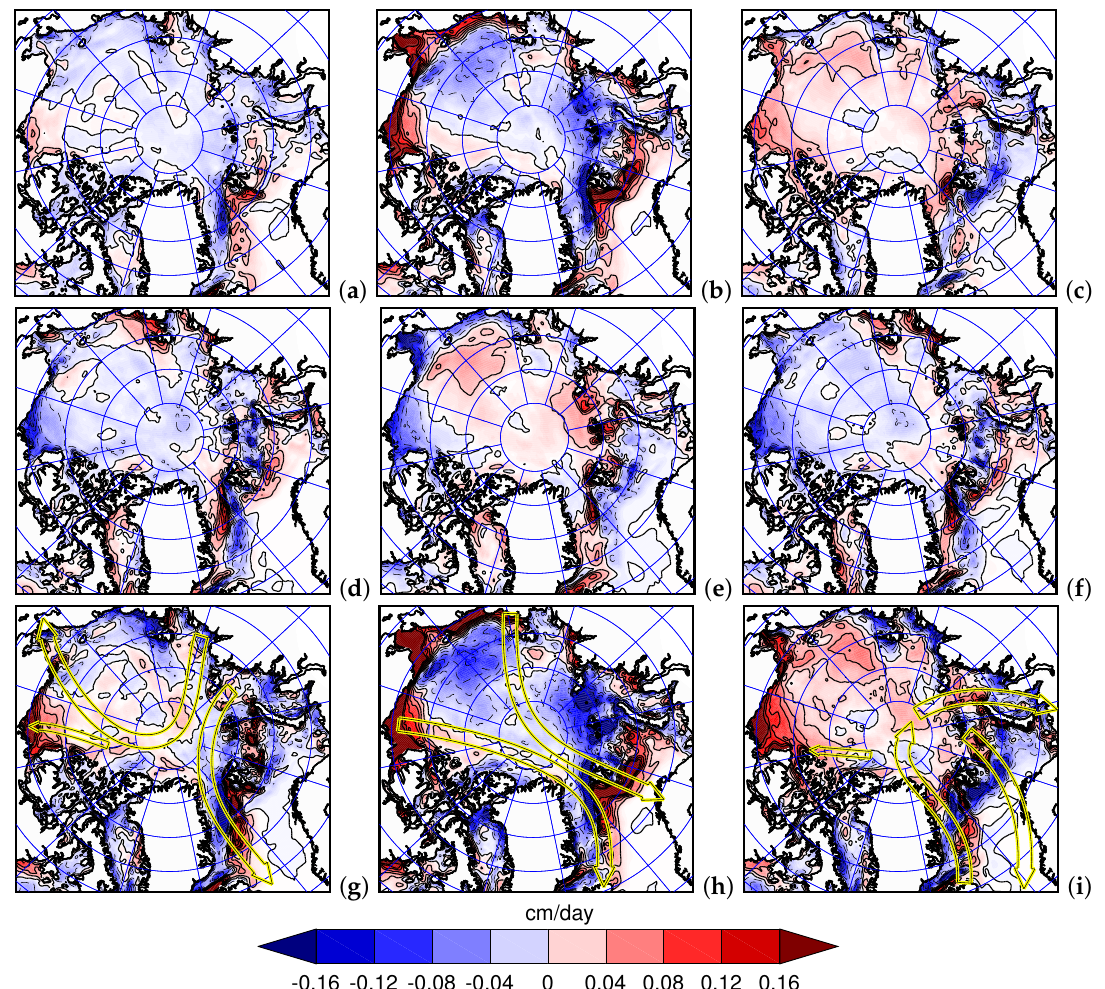
Figure 8. Ice growth rates due to thermodynamic factors (cm/day) associated with the first ( a , d , g ), second ( b , e , h ) and third ( c , f , i ) EOF modes of the surface wind decomposition: ( a – c ) the weighted average value of the growth rate for the periods of positivity of the principal components of the decomposition, ( d – f ) the weighted average value of the growth rate for the periods of negativity of the principal components, ( g – i ) the difference of the weighted average of the positive and negative phases (( g − − i ) = ( a − − c ) − ( d − − f )) . In the figures ( g – i ), yellow arrows schematically indicate the prevailing surface wind directions corresponding to the positive phases of the circulation